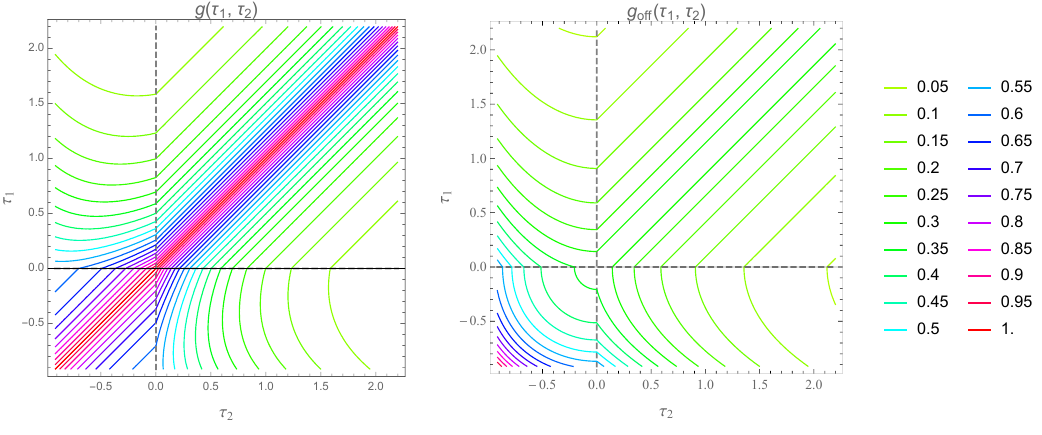
Figure 21 . The contour plot of the two time solutions for the overlap. In both side we plot e g ( (cid:28) 1 ;(cid:28) 2 ) and e g off ( (cid:28) 1 ;(cid:28) 2 ) as a function of (cid:28) 1 ; (cid:28) 2 . The parameters are taken to be (cid:20) (cid:13) = 0 : 9 and others are determined from (cid:20) (cid:11) =